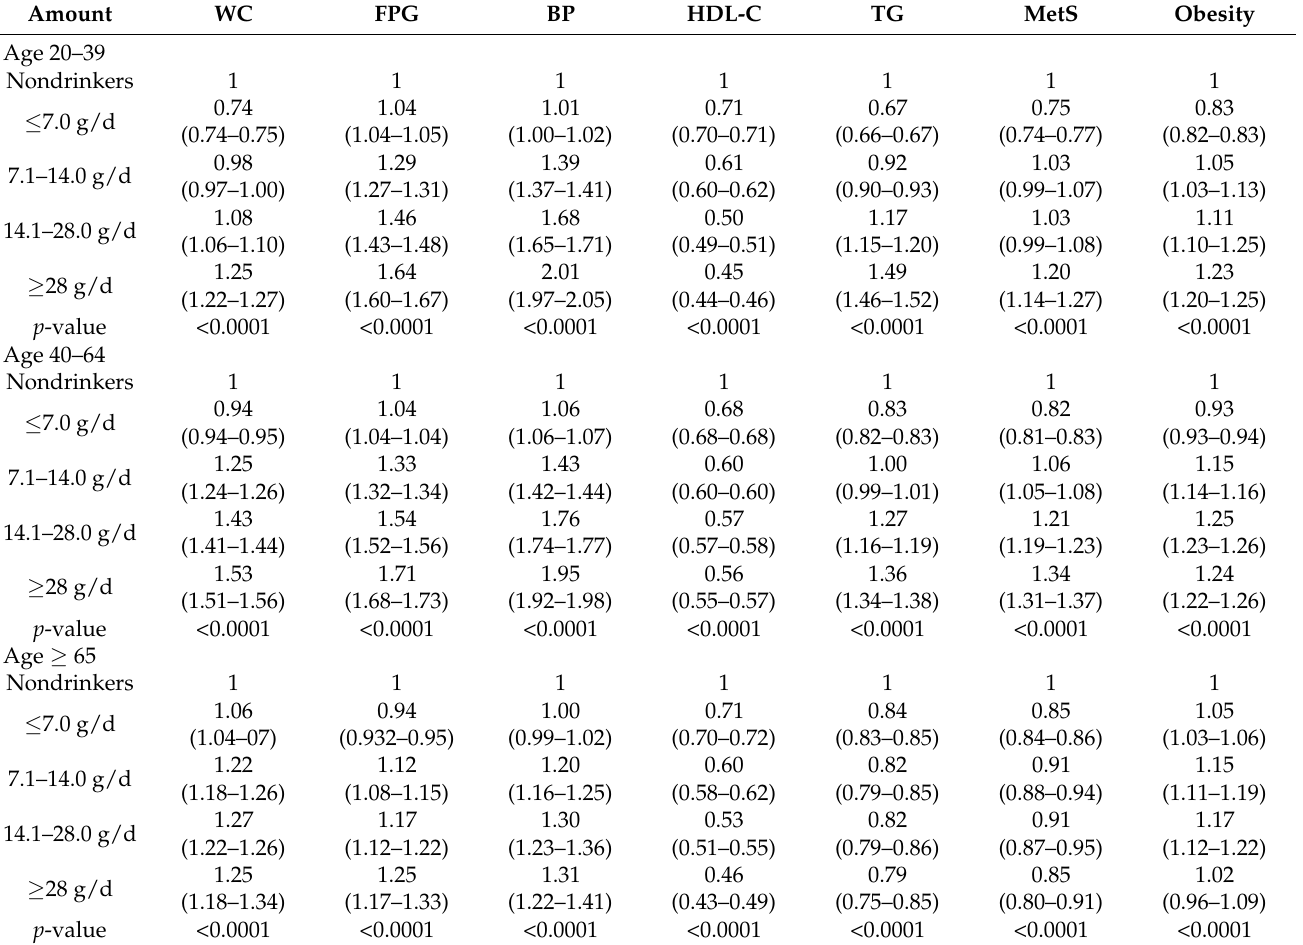
Table 5. Odds ratios of metabolic syndrome and obesity according to age in